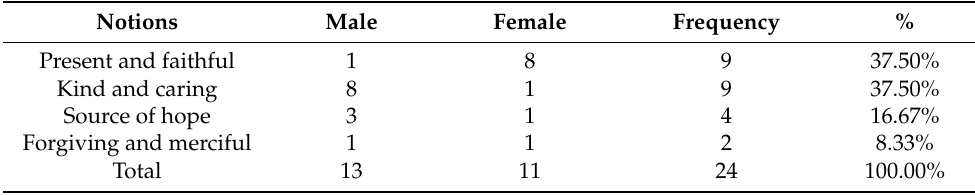
Table 1. Notions of God’s love by select Filipino Christian youths.